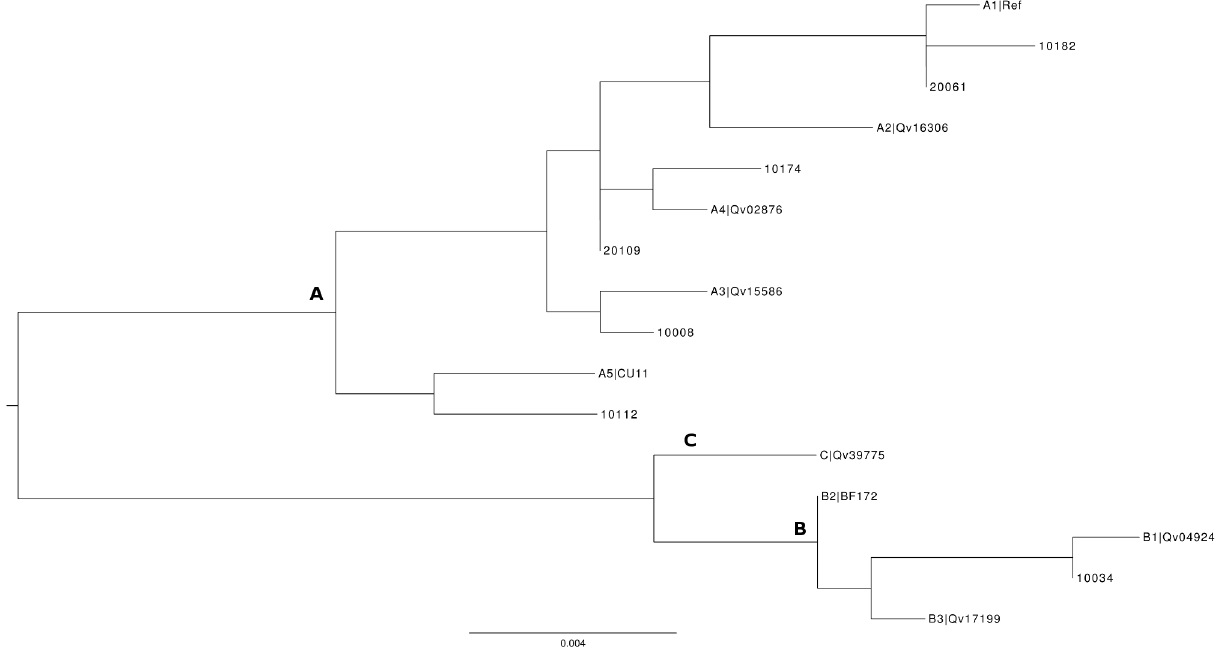
Figure 5. Phylogenetic tree of the HPV18 isolates based on LCR/E6 sequences. Phylogenetic analysis confirmed the presence of two lineages [4]: A and B. A maximum likelihood (ML) tree was inferred from an alignment of nine reference sequences and seven study sequences of HPV18 LCR-E6 using RAxML HPC v8 [22]. Highly related sequences ( , 0.4 differences) from the study were not included in this figure. Reference sequences were denominated as